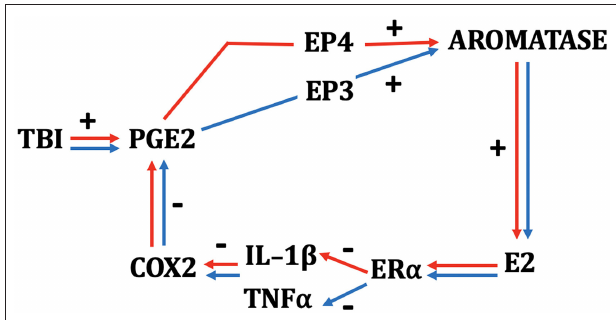
FIGURE 1 | Schematic depicting the interactions among TBI, neuroinflammatory indices, and neurosteroidogenesis in female (red) and male (blue) zebra finches. While many components of the schematic are monovalent between the sexes, PGE2 results in a more rapid upregulation of aromatase in females and depends on signaling via the EP4 receptor. Males show a slower increase in aromatase via PGE2 action on the EP3 receptor (64, 65). E2 acts on ER α in both sexes and downregulates COX2 by actions predominantly on IL-1 β in females and TNF- α in